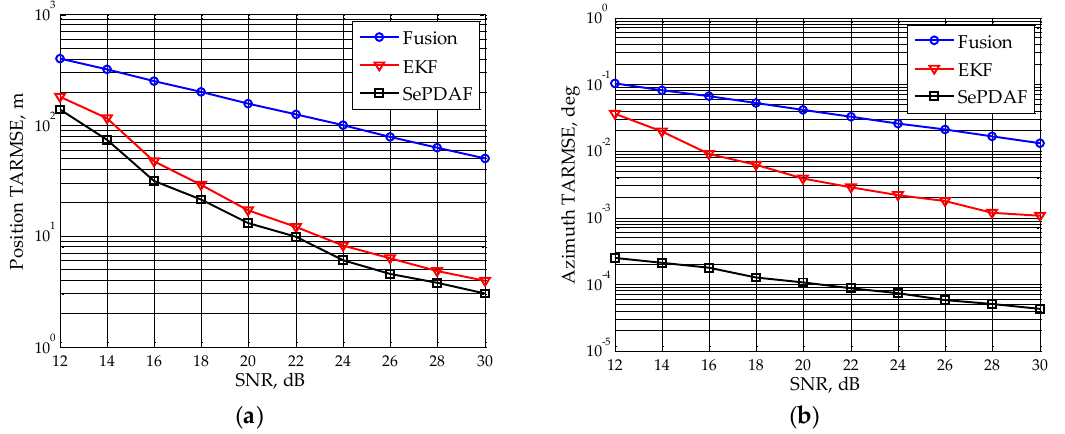
Figure 3. TARMSEs under different SNR after using the proposed method: ( a ) position RMSE; and ( b ) azimuth RMSE.